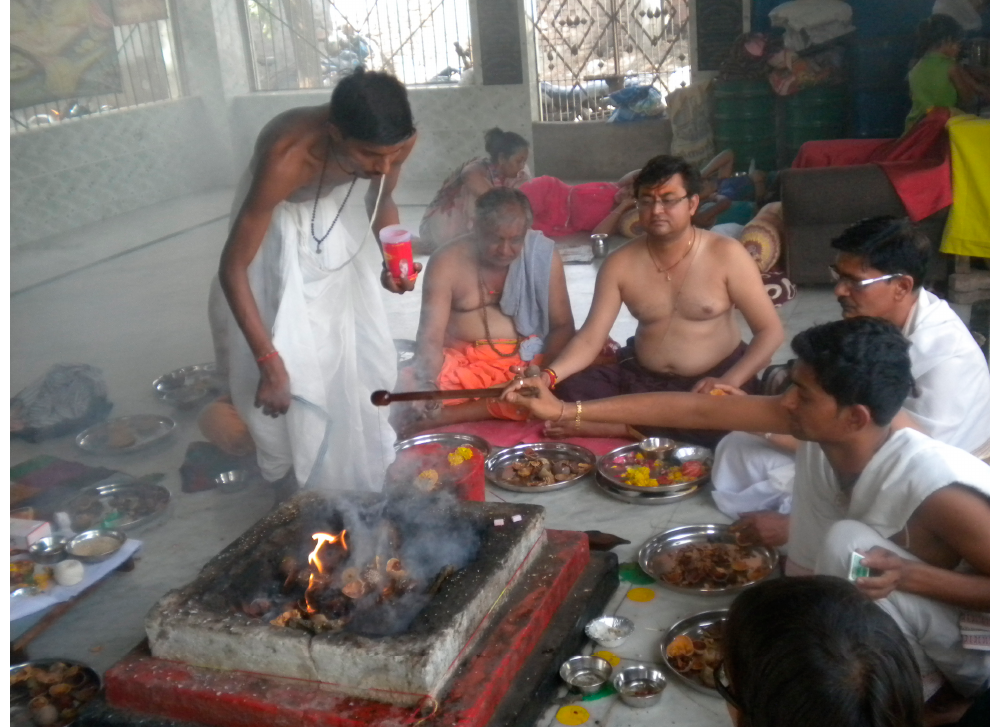
Figure 4. Dhananjay (center, shirtless with glasses) performing havan with the help of Brahmans. Dhananjay’s father is pictured to his immediate right. Photo by